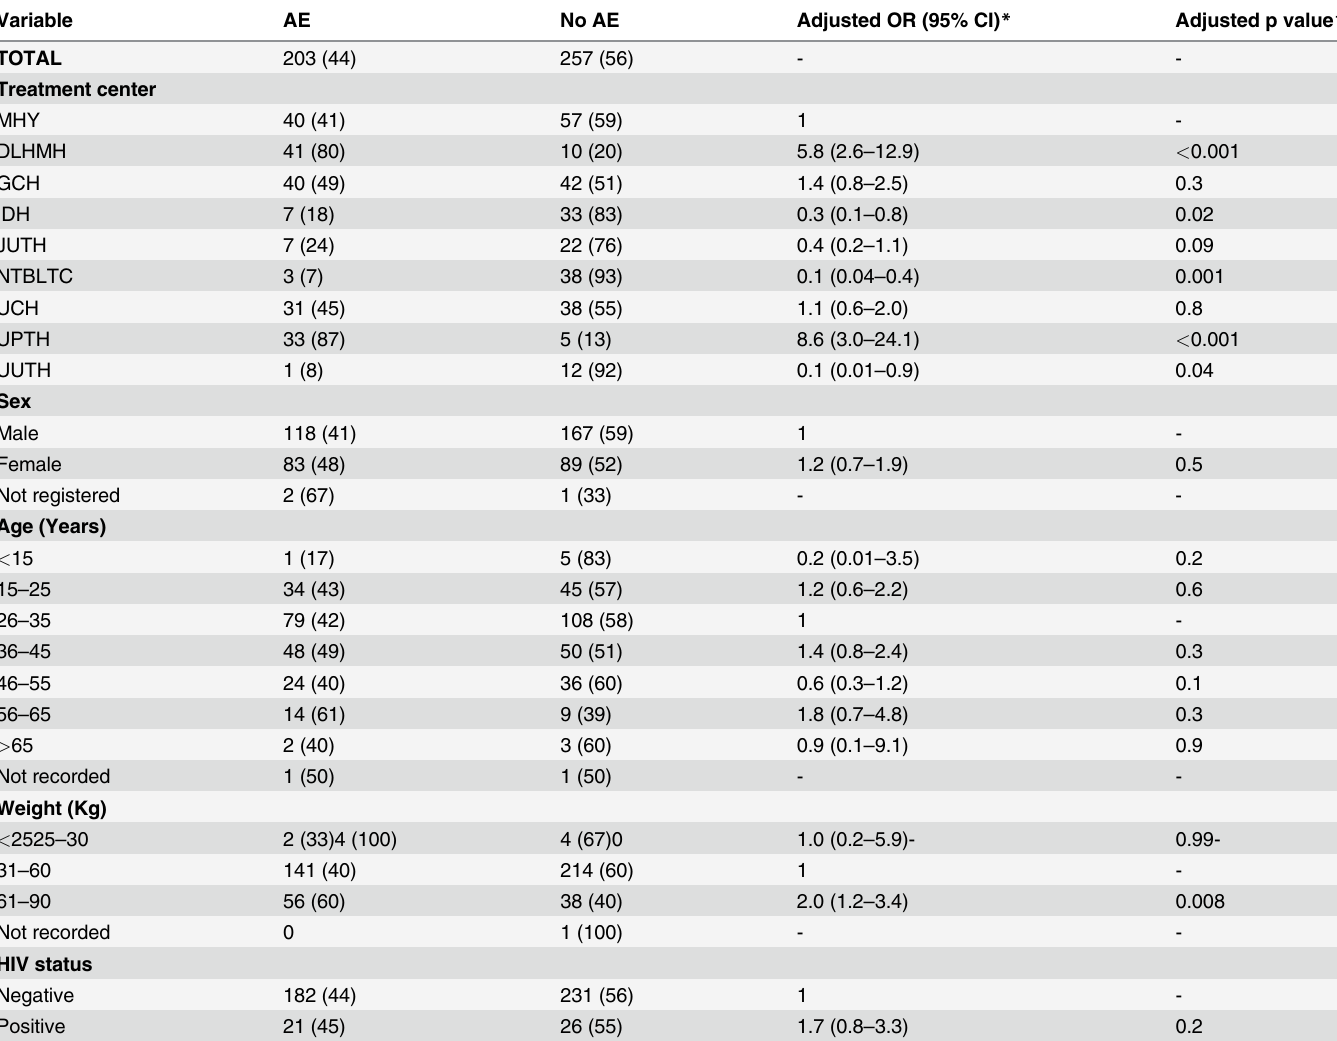
Table 4. Association between AEs, sex, age and body weight among MDR-TB patients admitted to in-patient care, Nigeria, 2012 – 2013. Variable